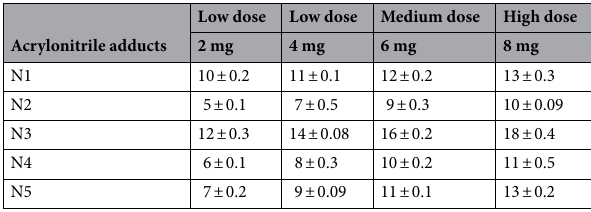
Table 1. Zone of inhibition (mean standard error) for E. coli .